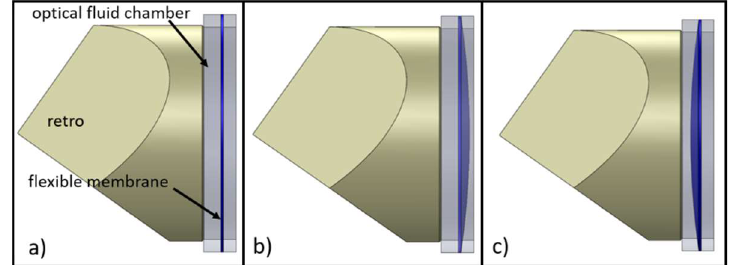
Figure 2. Schematic of an adaptive retroreflector using an optical liquid/fluidic: ( a ) flat ( b ) convex and ( c ) concave.